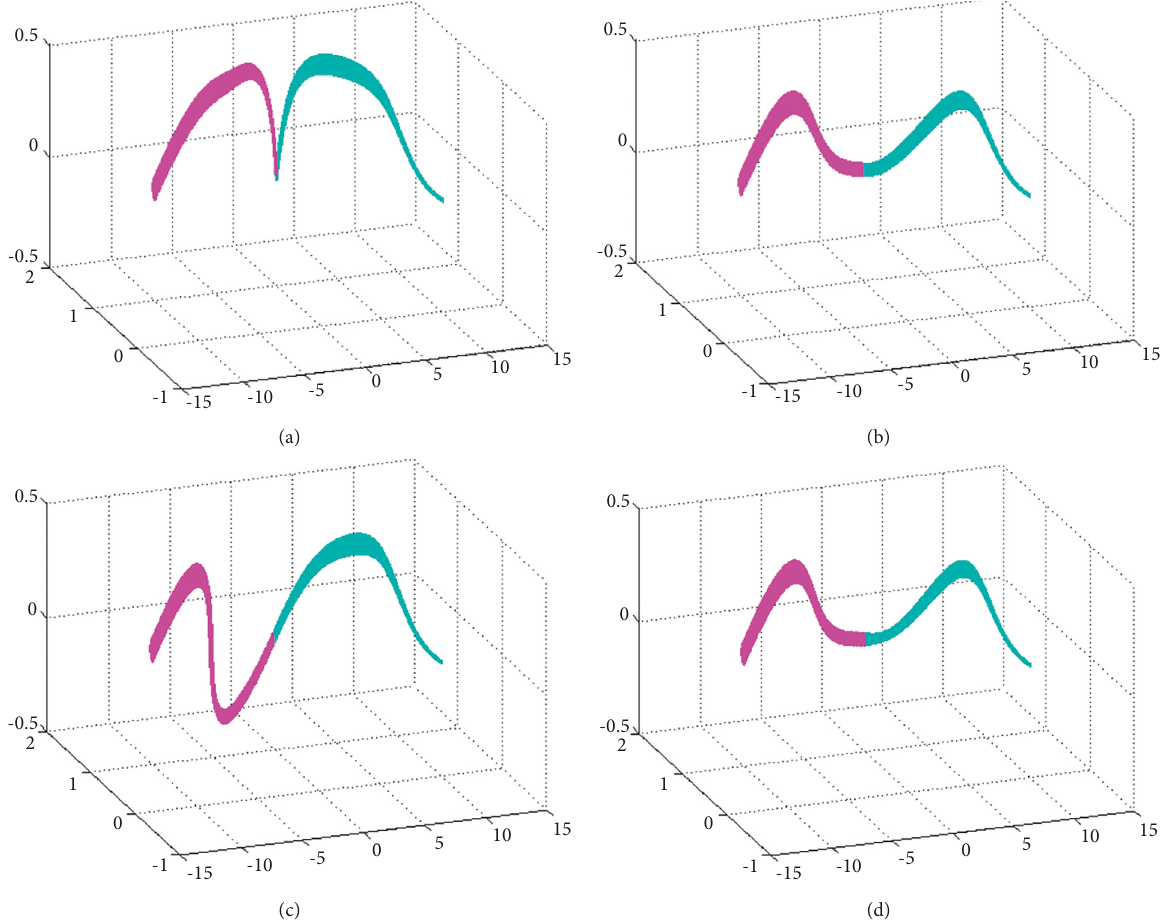
Figure 3: Smoothing two connected BBCs from C 0 to C 1 by minimizing the internal energy. (a) C 0 connection. (b) C 1 connection ( k